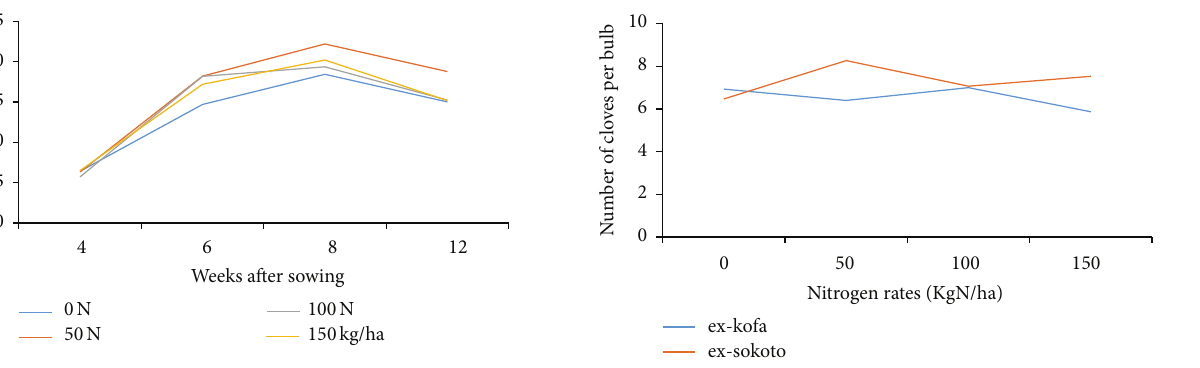
Figure 8: Significant ( 𝑝 < 0.05 ) growth trend of garlic response to different nitrogen rates at 4, 6, 8, and 10 weeks after sowing on leaf area during the period of the experiment.